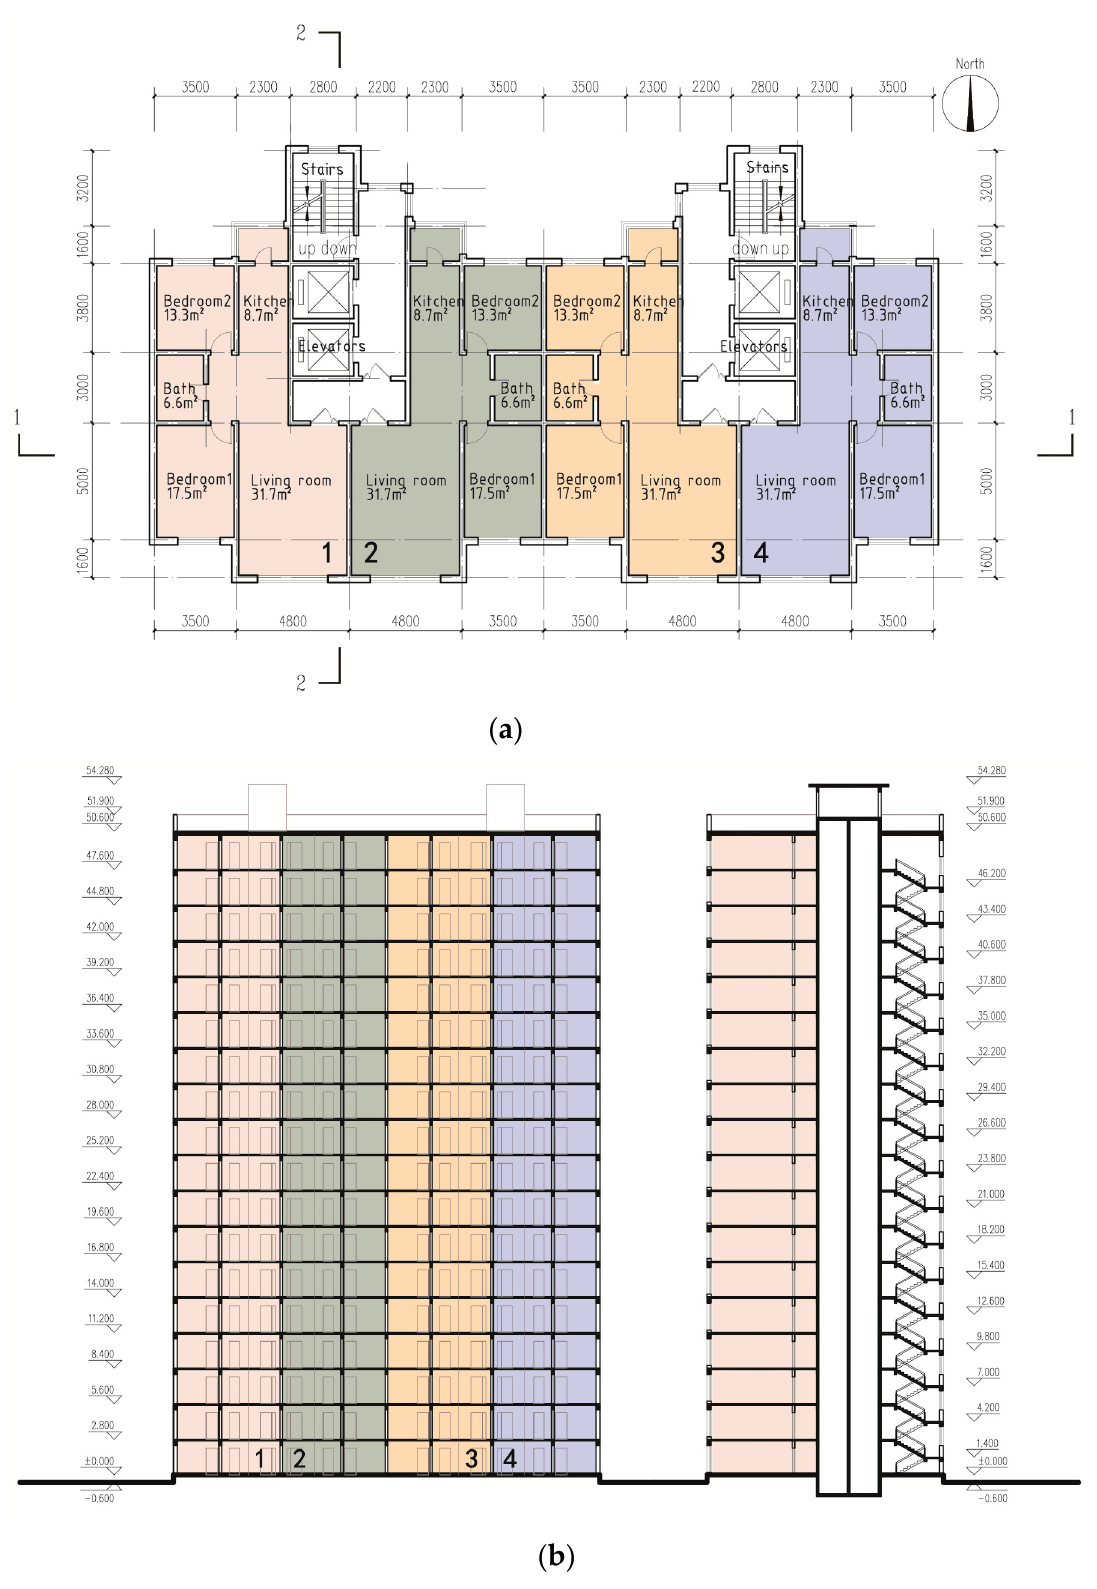
Figure 5. Details of the architectural design. ( a ) Standard floor plan of the residential case study building. ( b ) 1-1 and 2-2 sections of the